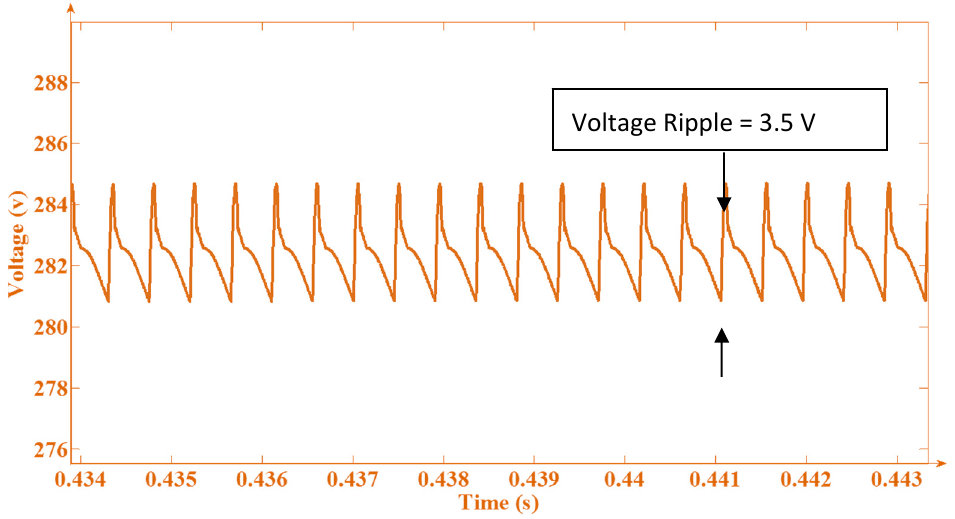
Figure 41. Ripple voltage waveform for fuzzy-based BDC.